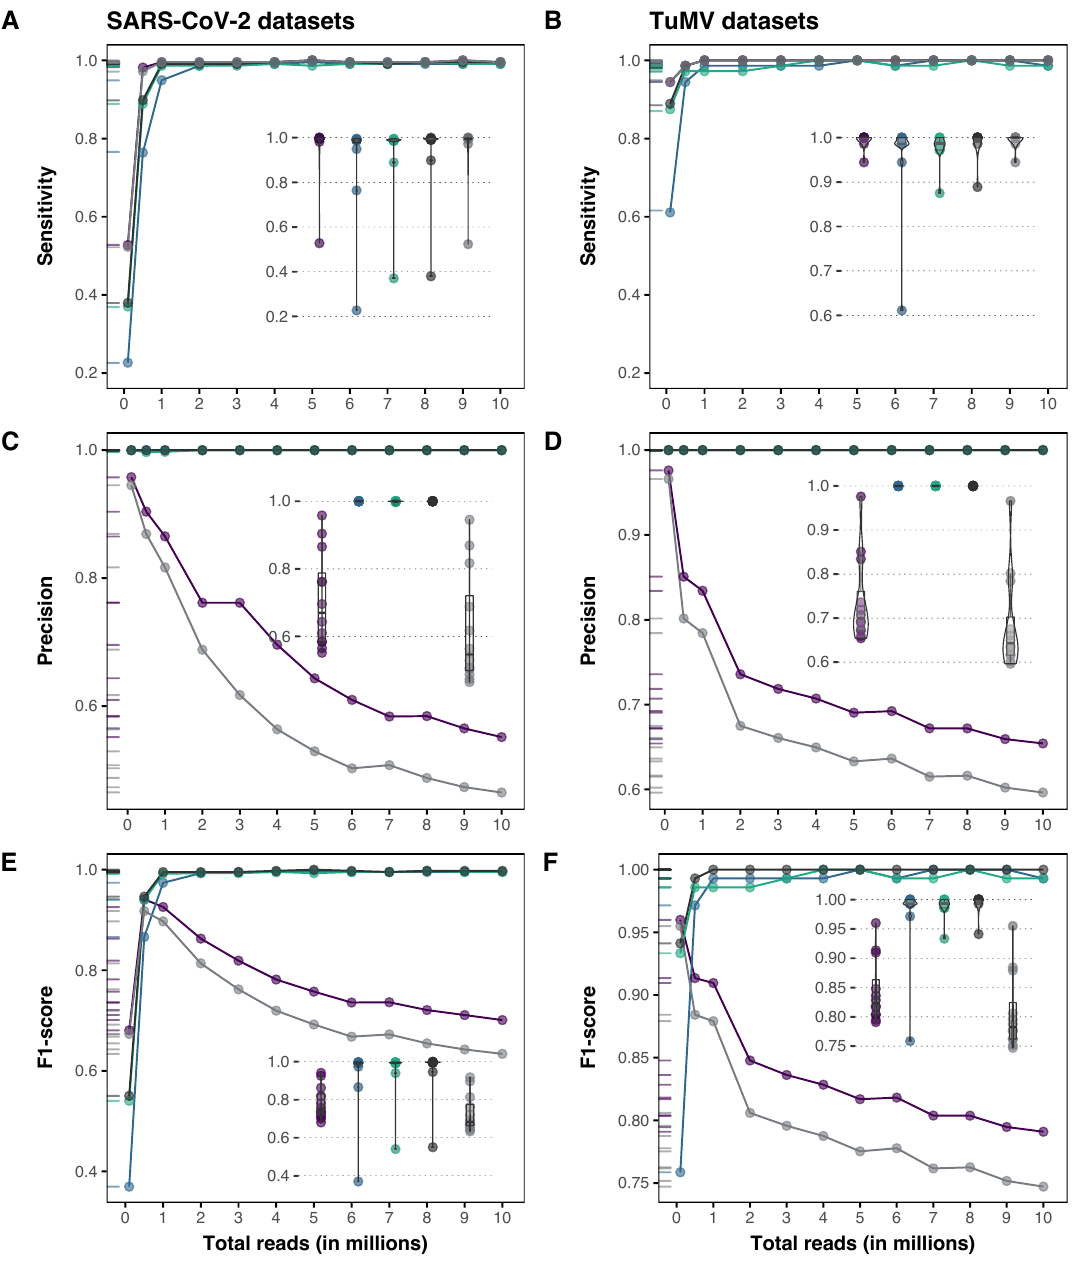
Figure 5. Performance of the three DVGfinder run modes (Metasearch, Consensus, and Filtered) and the two search algorithms (ViReMa-a and DI-tector) working separately on the synthetic samples generated from the SARS-CoV2 genome ( left column ) and TuMV genome ( right column ). Sensitivity ( A , B ), Precision ( C , D ), and F 1 score ( E , F ) were calculated in the twelve synthetic samples generated from each genome. An identified DVG was considered as TP if the sequence around its junction matched with the sequence of any DVG introduced in the synthetic dataset, directly or as reverse complementary. The scores for each run mode are represented in three different types of plots: line graphs show them in relation to the library size while box and rug plots show the distribution of each mode. Within each genome set, each sample contains the same composition in number and type of DVGs, the size of the library being the unique parameter of variation. The library sizes assessed (number of reads) were 10 5 , 5 × 10 5 , 10 6 , 2 × 10 6 , 3 × 10 6 , 4 × 10 6 , 5 × 10 6 , 6 × 10 6 , 7 × 10 6 , 8 × 10 6 , 9 × 10 6 , and 10 7